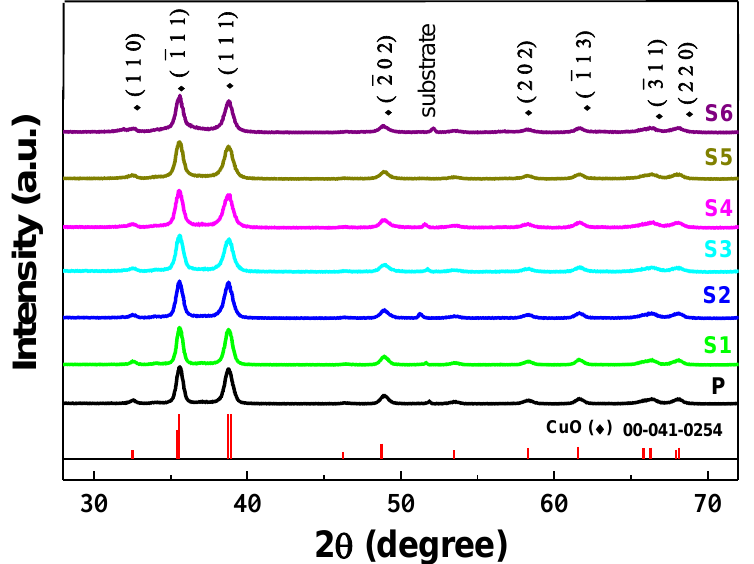
Figure 1. X-ray diffraction patterns of pure and Zn-doped CuO films. Figure 1. X-ray di ff raction patterns of pure and Zn-doped CuO films.